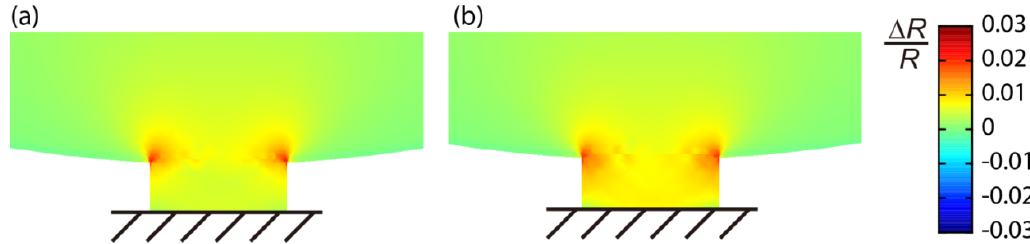
beams of the 2G-MSS chip passivated 2 N and ( b ) 80 nm of SiO 3 4